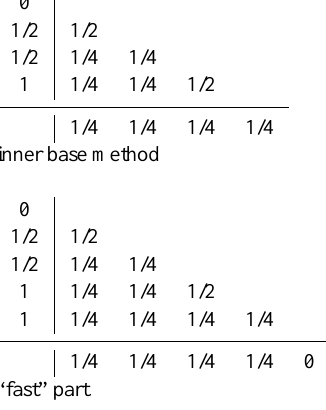
Table 1. RFMSMR(RK2a) – an example for a 2nd order multirate scheme with time step ratio R = 2; redundant stages omitted.